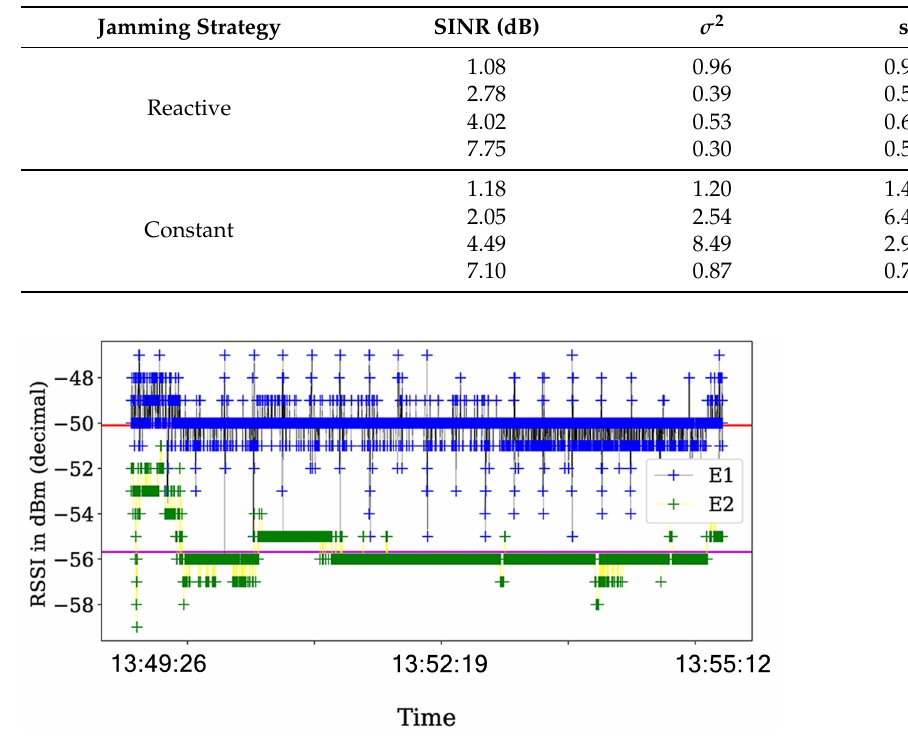
Figure 14. The ACK reports across the experiments and the presence of the impulsive noise in the range of 13:48:57 to 13:49:17 for both transmitters. The status reports expose that for that range of